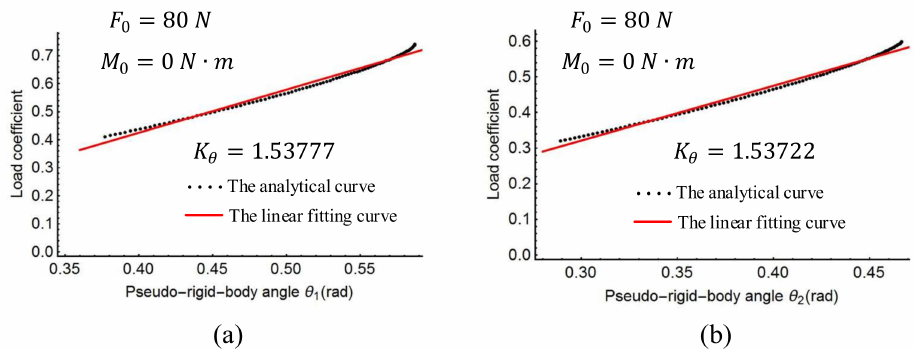
Figure 10. Linear regression of stiffness coefficient with action force angle: ( a ) rotation joints P 1 , ( b ) rotation joint P 2 .